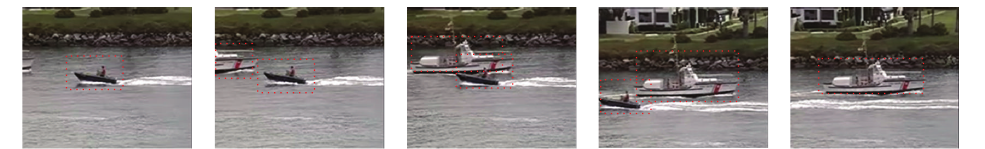
Figure 1: Tracking smooth movement targets (coastguard).